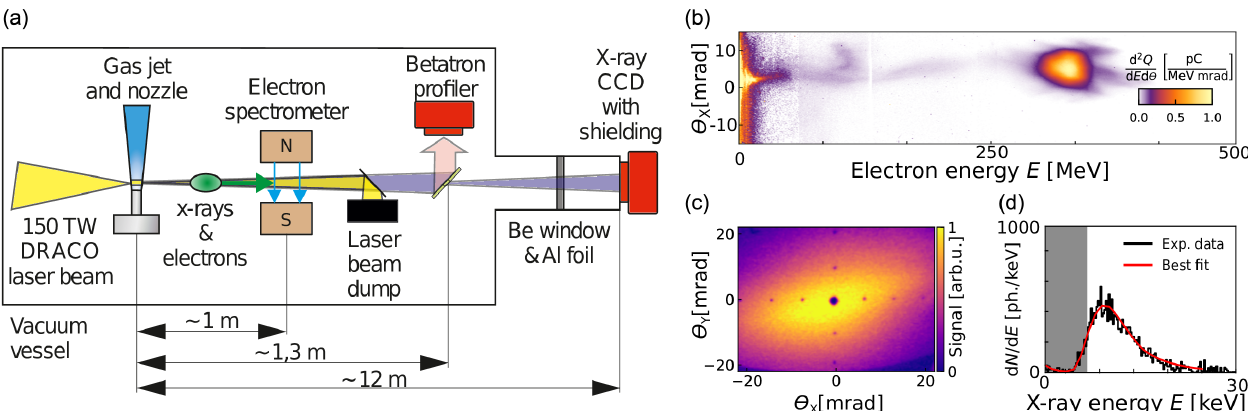
FIG. 2. The experimental setup is presented in (a) the laser is focused on a gas jet and drives a wakefield. Accelerated electrons are energy-analyzed in a magnet spectrometer, (b) illustrates a typical angle-resolved energy spectrum of electrons. An aluminum foil reflects residual laser light to a beam dump behind the spectrometer. As shown in (c), the betatron profiler intercepts the angular profile of the betatron radiation and on axis betatron radiation passes through a hole in the scintillator which is indicated by the black circular area in the center. Only the on axis part of the betatron spectra is detected by the x-ray camera, which is separated from the interaction chamber by a beryllium window. The reconstructed betatron spectrum is shown in (d). The gray area indicates photon energies that are not transmitted by the beam line. An aluminum filter foil attenuates the betatron